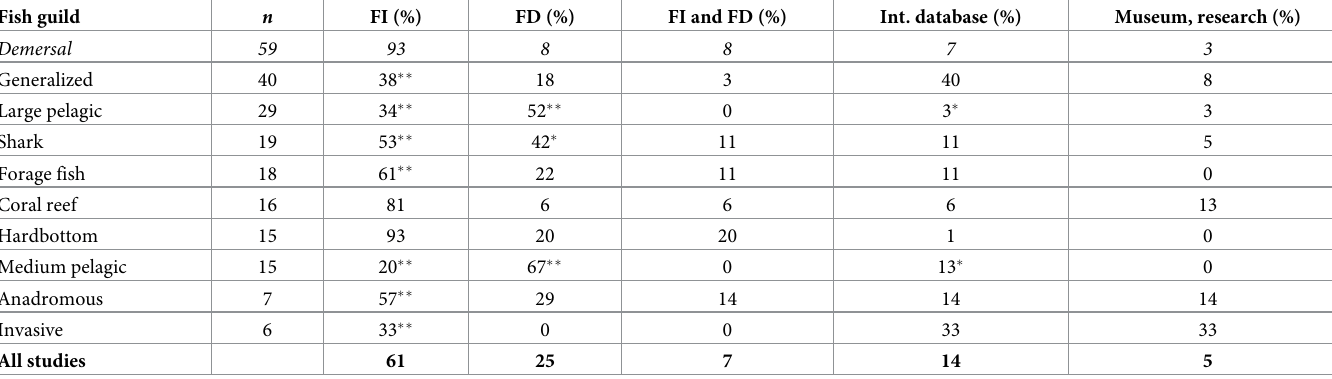
Table 1. Data sources of marine fish predictive modeling articles attained from the Web of Science database (2007–2018) by fish guild. Fish guild n FI (%) FD (%) FI and FD (%) Int. database